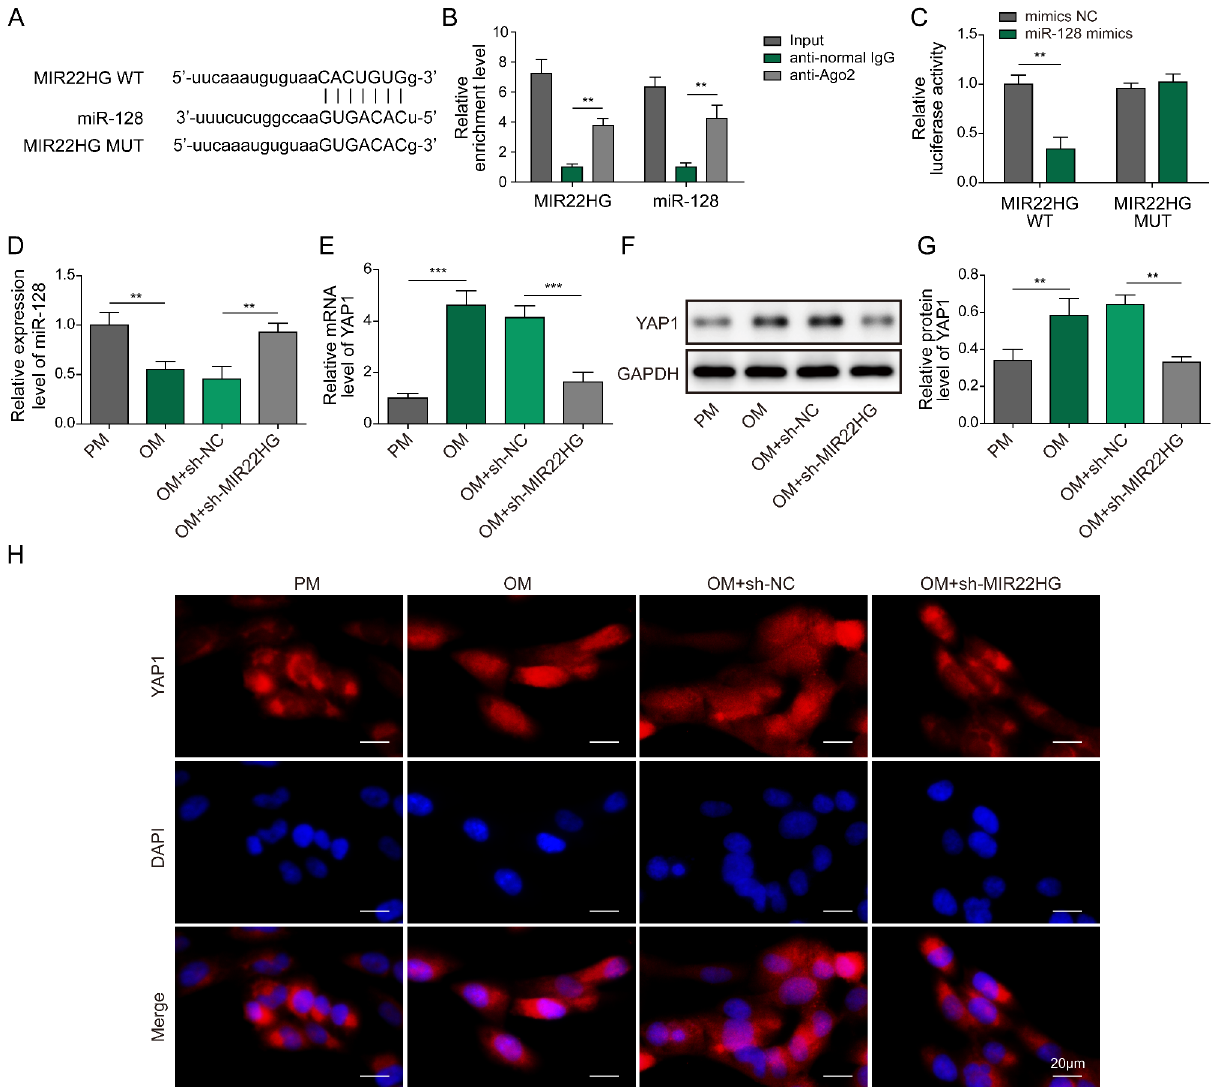
Fig. 5 MIR22HG sponges miR-128 to activate YAP signaling pathway. (A) Starbase database predicted the binding sites of MIR22HG in miR-128. (B) RIP and (C) Dual-luciferase reporter assays confirmed the interaction between MIR22HG and miR-128. (D) miR-128 and (E) YAP1 mRNA levels in BMSCs from PM, OM, OM + shNC, OM + shMIR22HG were determined by qRT-PCR. (F&G) Western blotting analysis of YAP1 protein levels in BMSCs with various treat- ments. (H) The subcellular distribution of YAP1 in BMSCs was evaluated by immunofluorescence staining. ** P < 0.01 and *** P <